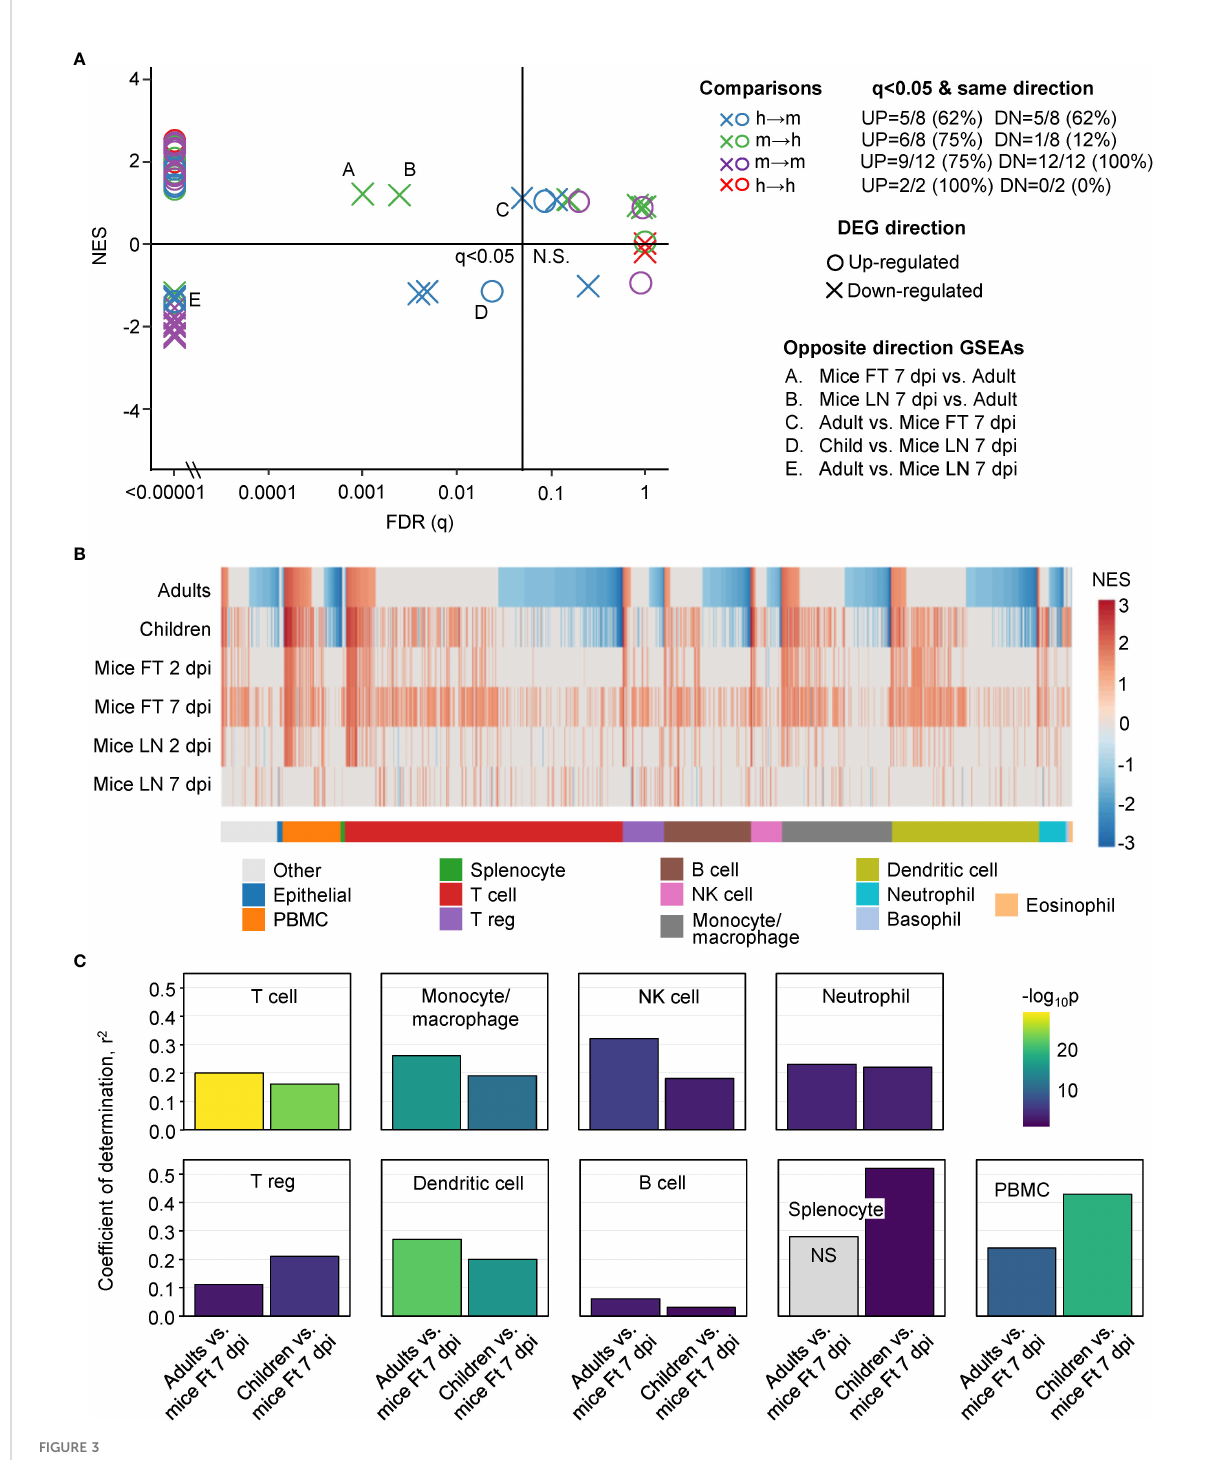
FIGURE 3 GSEAs between groups and using ImmuneSigDB gene sets. (A) Reciprocal GSEAs using genes lists ranked by fold change and up- and down- regulated DEG lists from each group. Most GSEAs were signi fi cant (left of q=0.05 line), with the number of signi fi cant GSEAs over the number of GSEAs provided top right (q<0.05 & same direction). Five GSEAs gave opposite direction; e.g. up-regulated orthoDEG sets signi fi cantly enriched in the down-regulated ranked gene list (Opposite direction GSEAs). (B) GSEAs using up-regulated gene sets from ImmuneSigDB and gene lists ranked by fold change for all the groups. GSEAs signi fi cant in at least one group are segregated by cell type (mentioned in the ImmuneSigDB annotation) and ranked by Adults. Blue represents up-regulated ImmuneSigDB gene sets that are enriched in the down-regulated genes in the ranked gene lists. (C) For the GSEAs shown in b, NES for Adults vs. Ft 7 dpi and Children vs. Ft 7 dpi were plotted for the indicated cell types and Pearson correlation coef fi cients and signi fi cance values